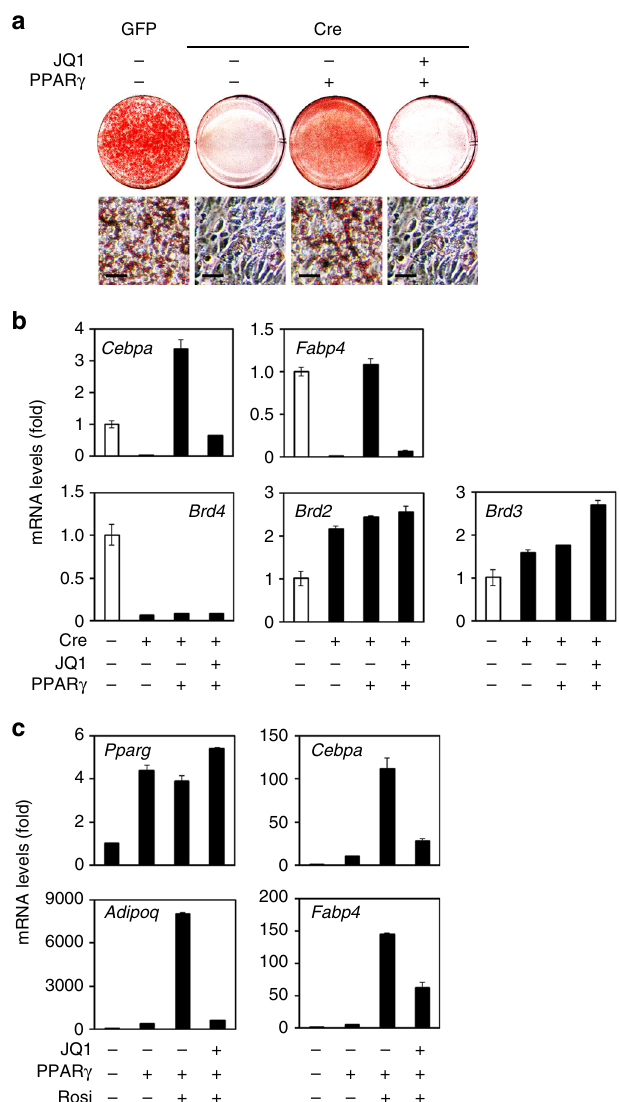
Fig. 9 JQ1, but not the single KO of Brd4, blocks PPAR γ -stimulated adipogenesis. a , b Brd4 f/f brown preadipocytes were infected with adenoviral GFP or Cre. Cre-infected cells were further infected with retroviruses expressing vector alone or PPAR γ . After hygromycin selection, cells were induced for adipogenesis assay in the presence or absence of 0.5 μ M BET inhibitor JQ1. a Oil red O staining at D7 of adipogenesis. Scale bars = 15 μ m. b qRT-PCR of Cebpa , Fabp4 , Brd4 , Brd2 , and Brd3 at D7 of adipogenesis. c BET family proteins are required for ligand-induced PPAR γ target gene expression. Subcon fl uent Brd4 f/f preadipocytes expressing ectopic PPAR γ were pretreated with JQ1 (0.5 μ M) for 3 h followed by treatment with 1 μ M rosiglitazone (Rosi) for 24 h in the presence of JQ1. The data are presented as means ± SD. Three technical replicates from a single experiment were